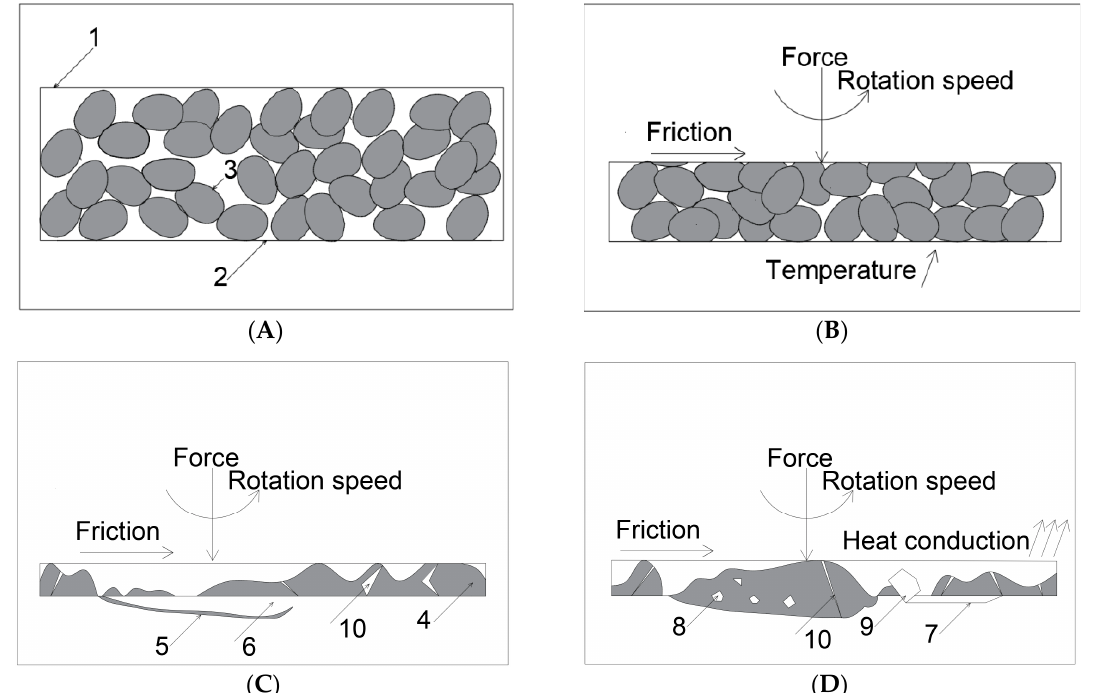
Figure 17. Model for the formation of unstable coal films; ( A )—preliminary phase, ( B )—initial compaction phase, ( C )—compaction and surface protection phase, ( D )—phase of chipping and inactivation of wear products; designations: 1—upper sample, 2—lower sample, 3—coal grains, 4—compacted coal film, 5—fissure filled with coal, 6—flat fatigue chipping, 7—microcut, 8—fragmented chippings in the coal film, 9—incompletely fragmented chipping particle, and 10—discontinuity of the layer.